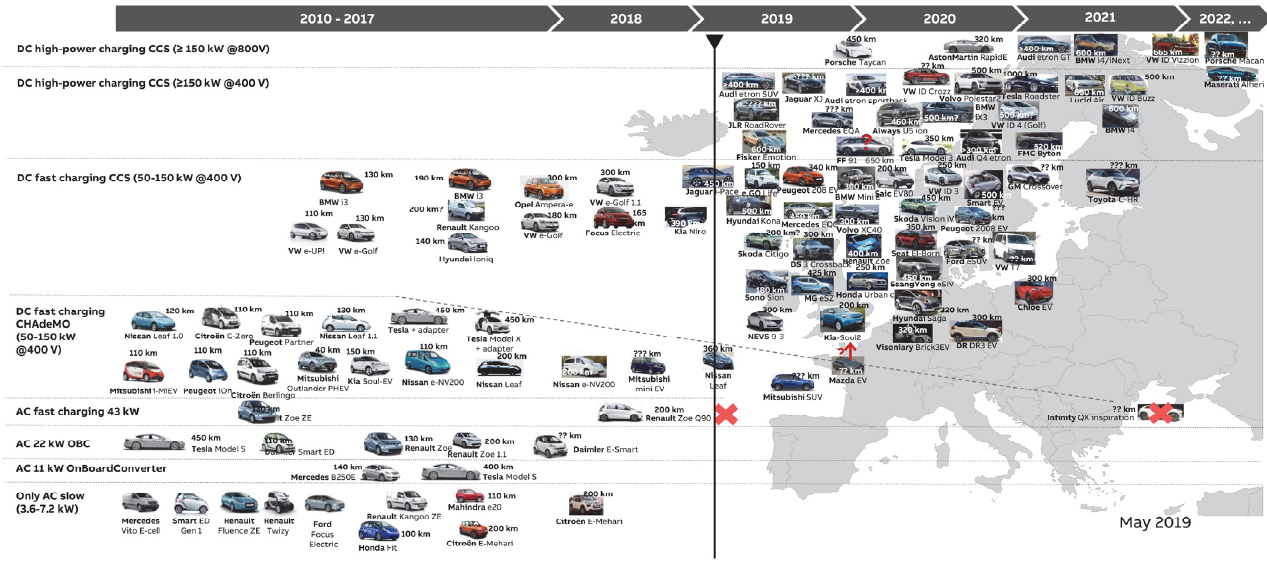
Figure 3. Evolution of EV range and charging capability. (Reprinted with permission from Ref. [29]. Copyright 2019 ABB.)